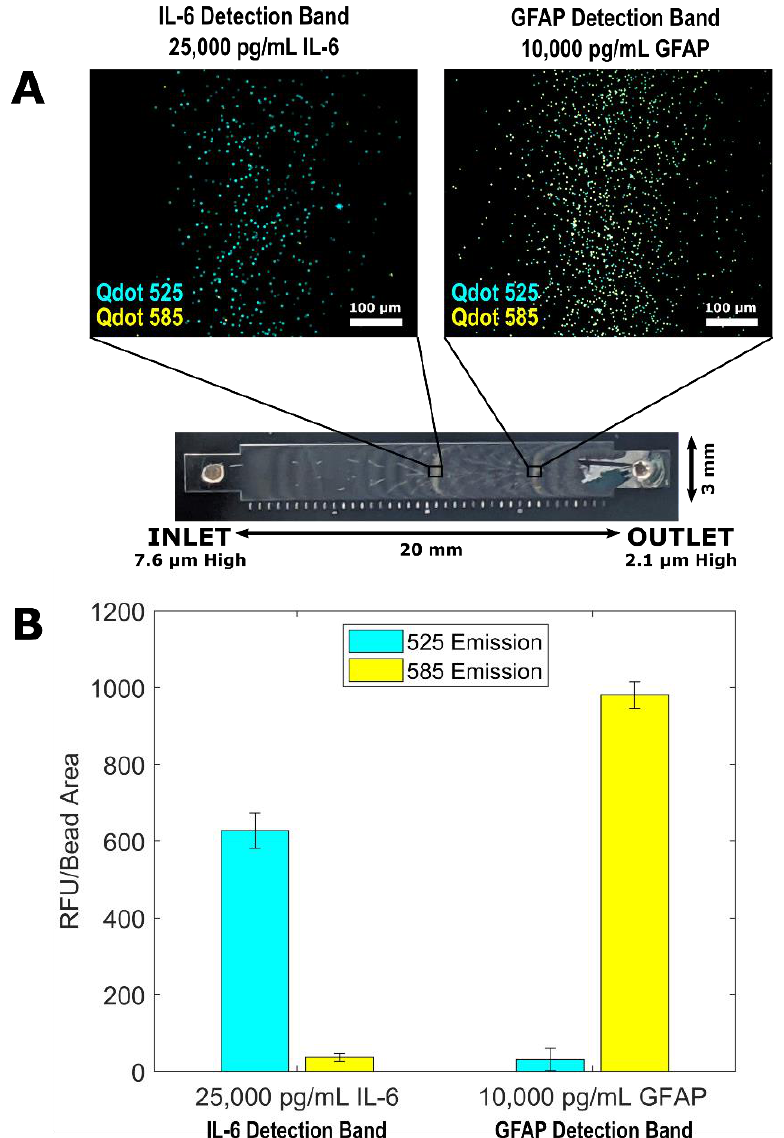
Figure 3. Multiplex of the IL-6 QLISA (fluorescent signal from Qdot TM 525) and the GFAP QLISA (fluorescent signal from Qdot TM 585) where the sample consisted of 25,000 pg/mL IL-6 and 10,000 pg/mL GFAP. ( A ) Representative images of ~4.5 µm beads trapped in the IL-6 detection band of the variable height device (left) and ~2.8 µm beads trapped in the GFAP detection band (right). Each image is an overlay of the Qdot TM 525 and Qdot TM 585 channels, and the brightness/contrast was set for ease of viewing. ( B ) The fluorescence intensity values from the Qdot TM 525 (blue) and Qdot TM 585 (yellow) channels for each variable height device detection band shown in ( A ) with the control values subtracted. The error bars are standard error of the mean and represent the variability in fluorescence intensity between the fields of view within each detection band.